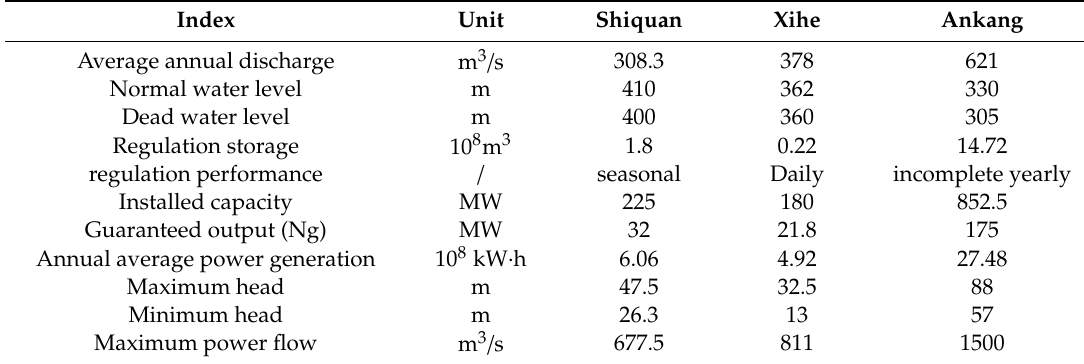
Table 1. The characteristics of the cascade reservoirs of Shiquan, Xihe, and Ankang hydropower